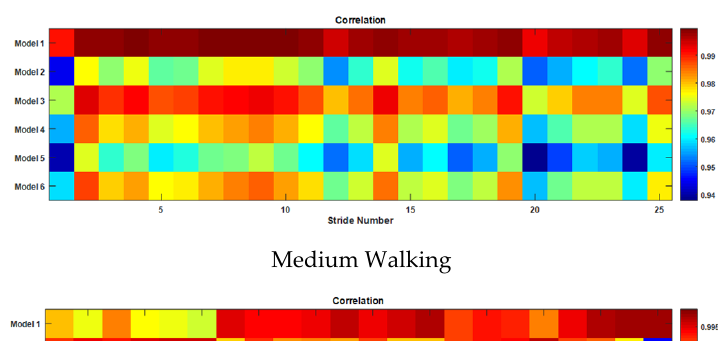
13 of 18 Figure 15. Thigh angle waveform reconstructed using a harmonic model with five harmonics and the original thigh angle waveform for a long walk. 3.4. Classifying Strides Using the Harmonic Model